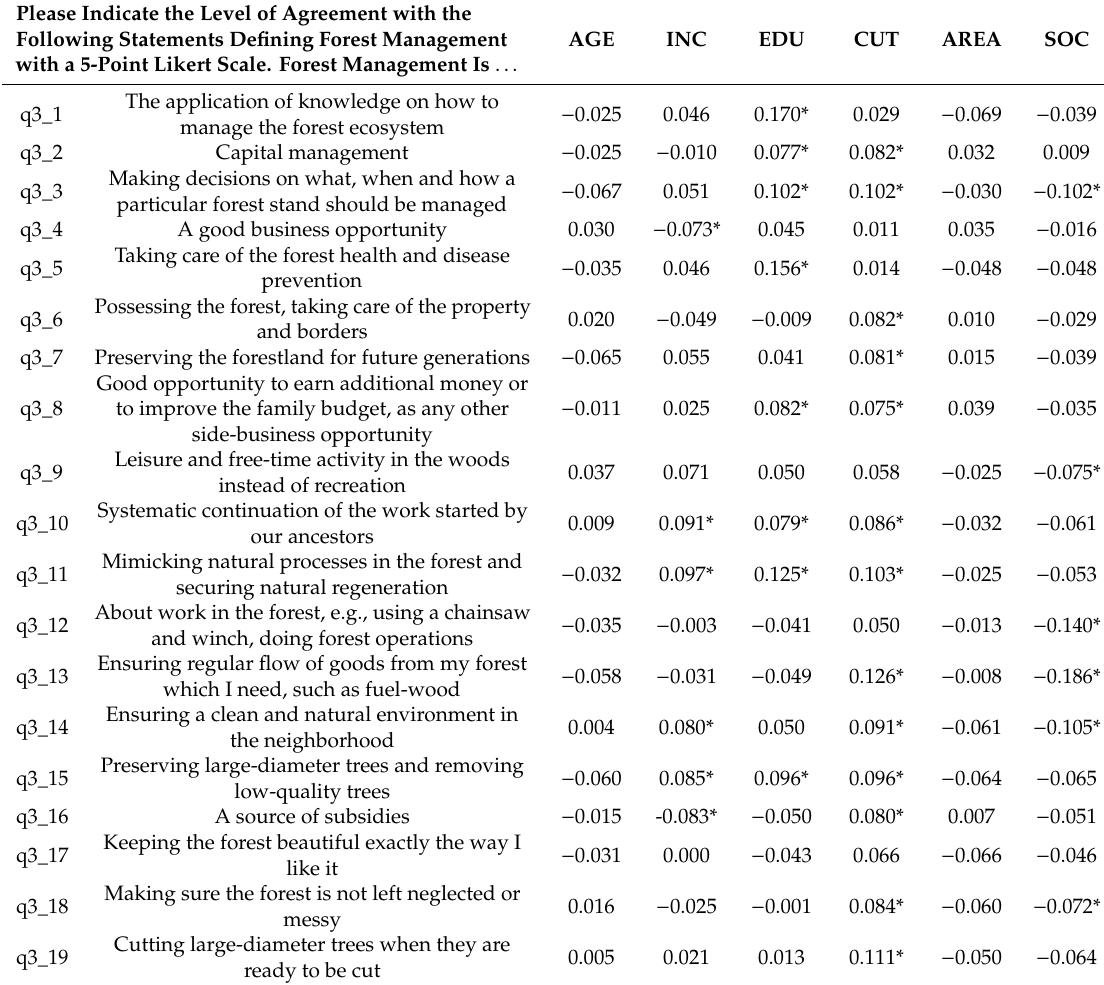
Table 2. Statements defining forest management (q3_1 to q3_19) and Spearman’s rank correlation with structural attributes (* correlation coe ffi cients significant at the p < 0.05